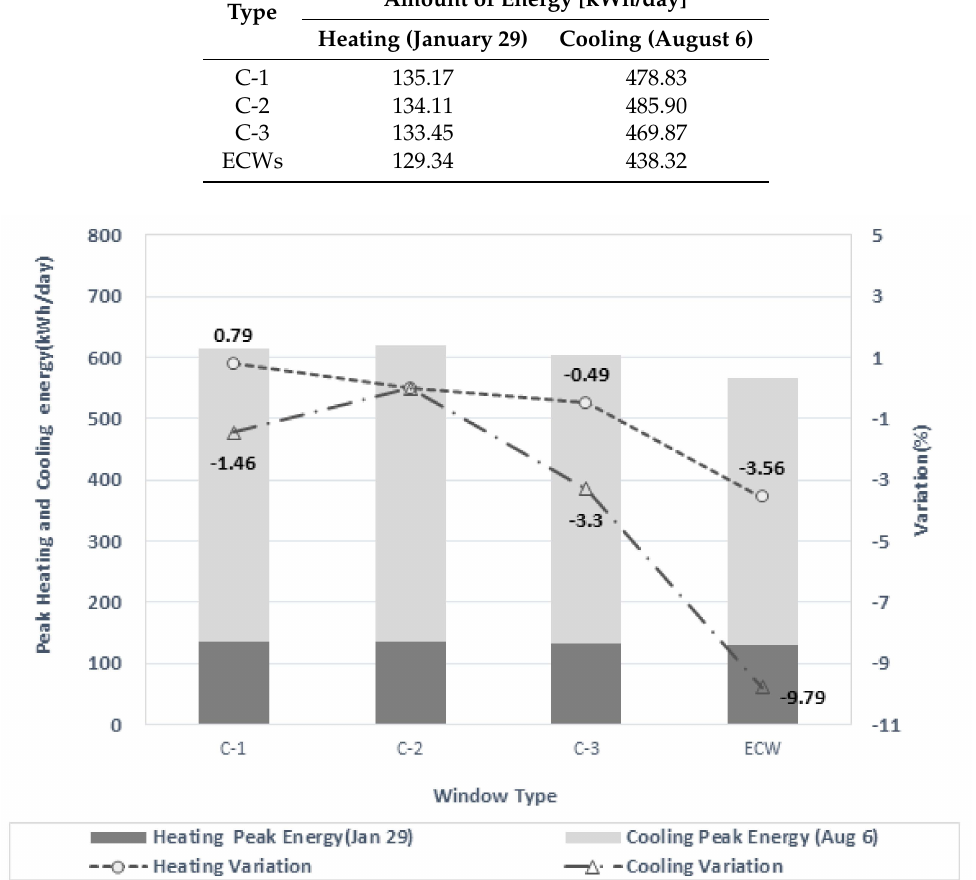
Figure 12. Peak Heating and Cooling energy consumption. (Variation: A percentage change compared to base model(C-2)).